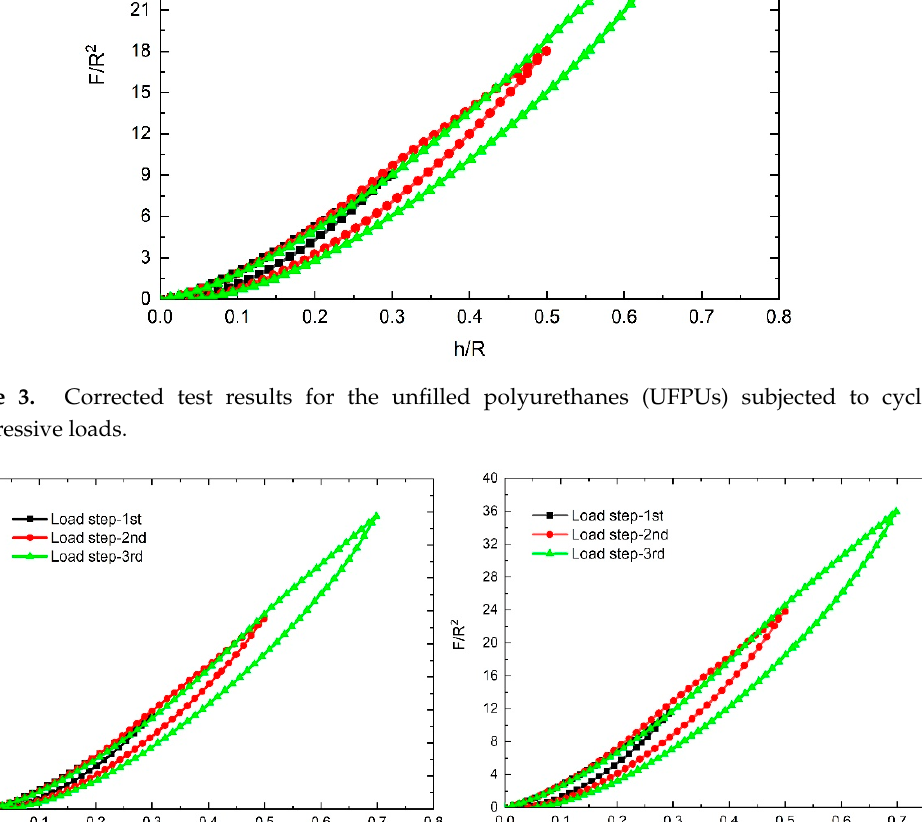
Figure 4. Test results for the nanoparticle-filled polyurethanes (NPFPUs) subjected to cyclic compressive load: ( a ) filled with 5 parts per hundred resin (phr) nano-silica; ( b ) filled with 10 phr nano-silica.